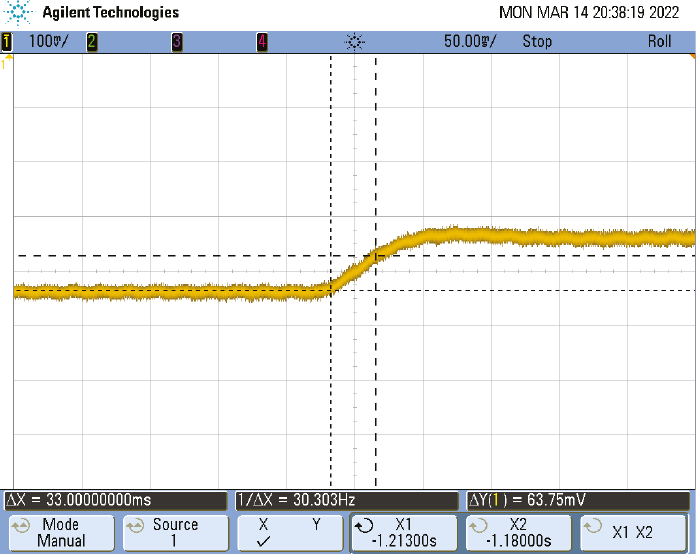
Figure 6. Step response of experimental transducer setup (see Figure 3) recorded by digital oscillo- scope. Cursors represent measurement of time constant (33 ms), which leads to cutoff frequency of 4.8